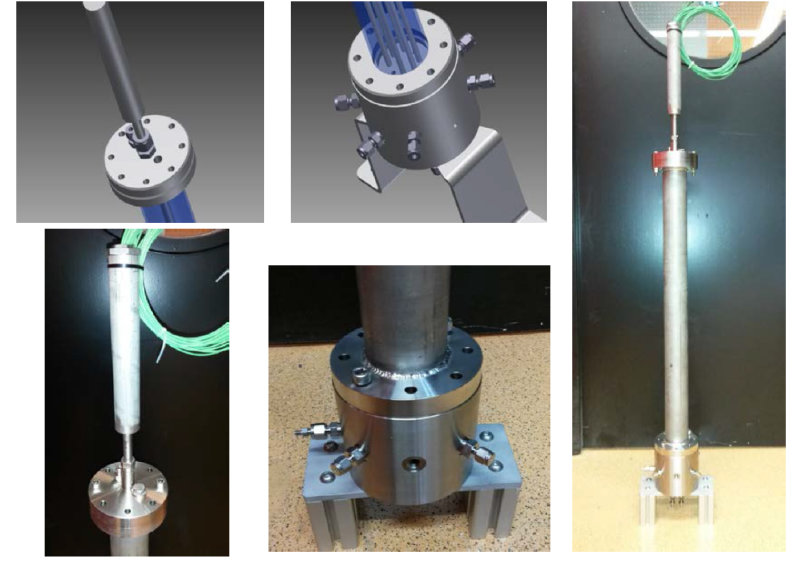
Figure 7. Parts of the new reactor as designed and built and final reactor assembled.